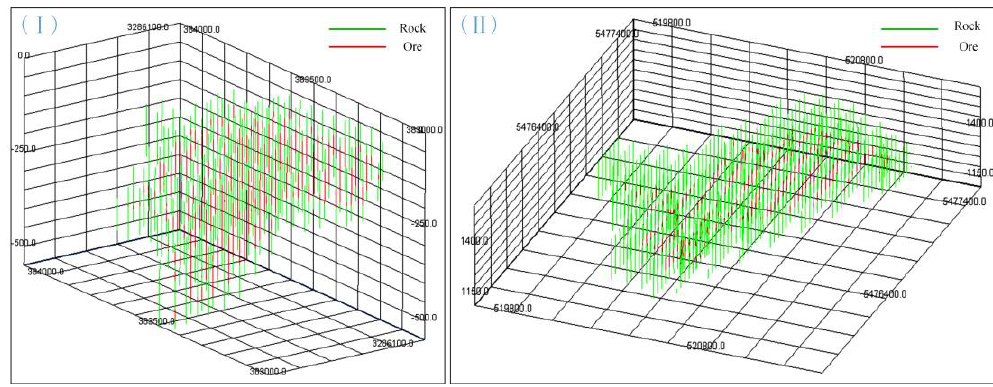
Figure 6. Borehole Data for Case I and Case II. Minerals 2018 , 8 , 443